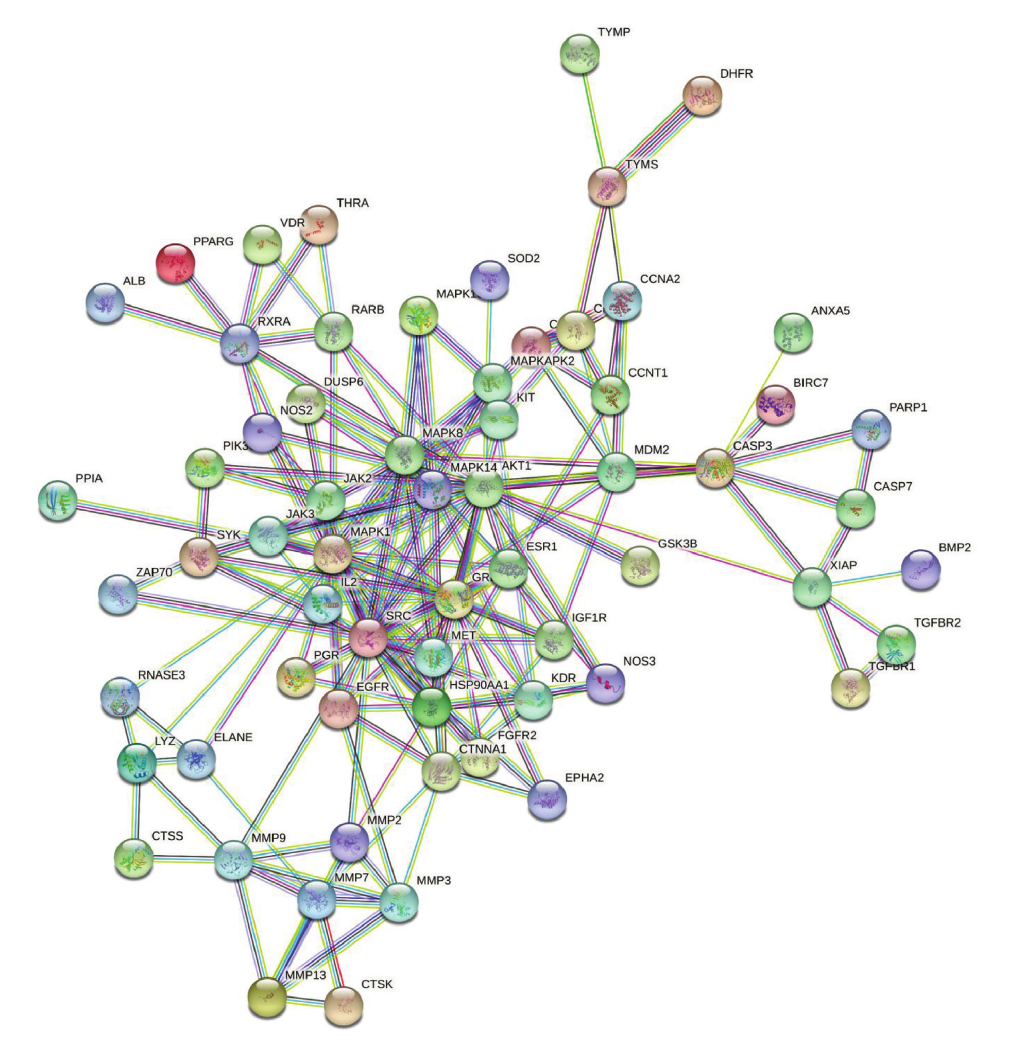
Figure 3: The PPI network model of PP2 against